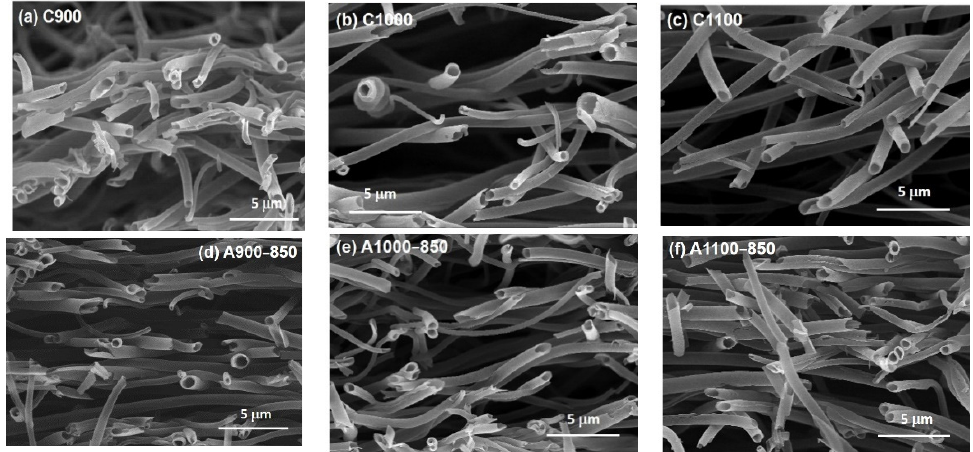
Figure 1. Field emission scanning electron microscopy (FESEM) images of the samples: ( a ) C900;